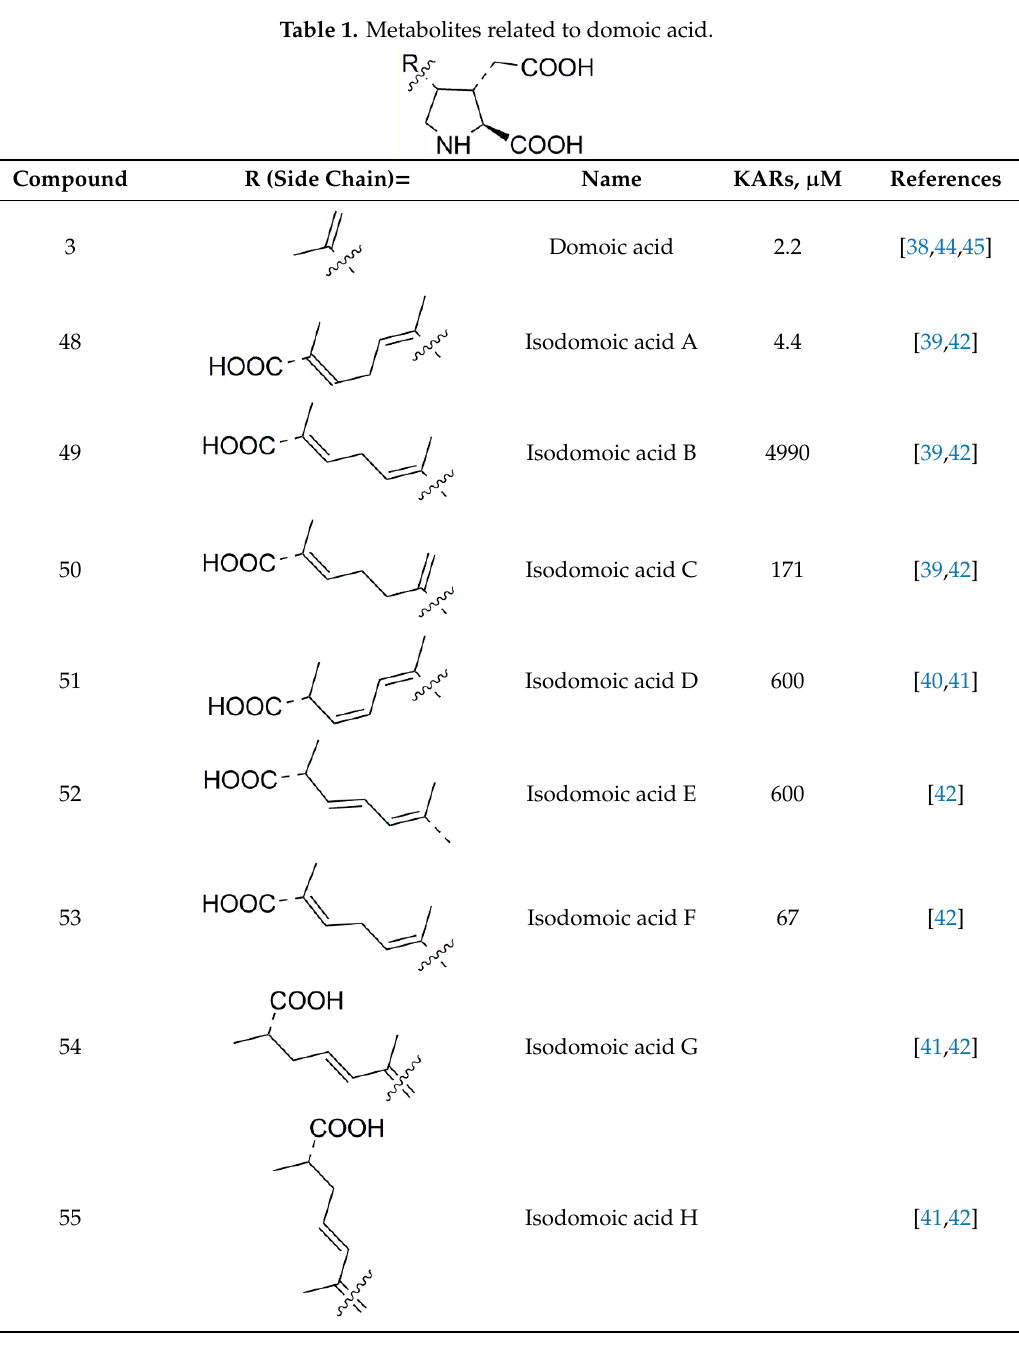
KARs, μ M= displacement of kainic acid from the complex with kainate receptors. KARs, µ M = displacement of kainic acid from the complex with kainate